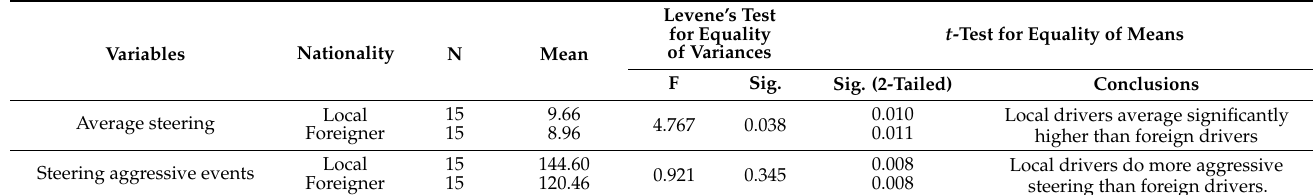
Table 5. Statistical differences in cultural background group.